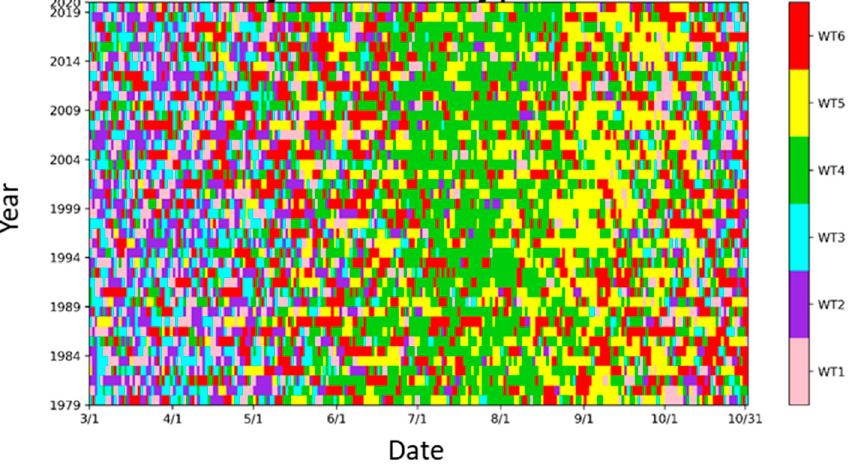
Figure 7. Depiction of the occurrence of different synoptic classification over the SEUS as a function